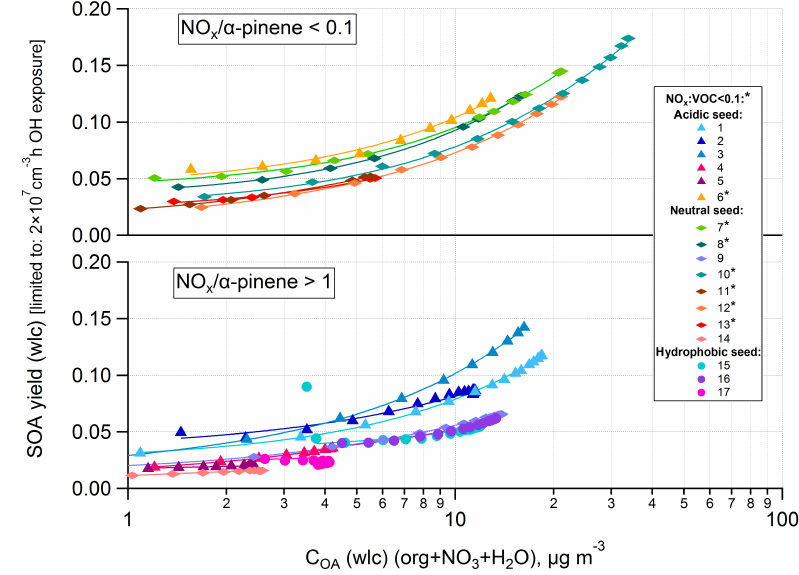
Figure 5. Measured (symbols) and parameterized (lines) wall-loss-corrected SOA yield, Y , as a function of wall-loss-corrected absorptive mass concentration (C OA : organics + NO 3 + H 2 O) for low NO x experiments (upper panel) and high NO x experiments (lower panel). Data were limited to an OH exposure of 2 × 10 7 cm − 3 h and averaged over 20min. Symbol colours indicate the RH, symbol shapes the seed composition and the asterisks the NO x / VOC